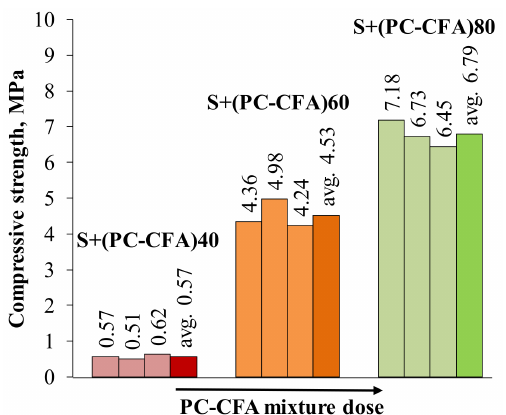
Figure 4. Dependence of the compressive strength of the monoliths with benzene-contaminated soil on PC-CFA mixture